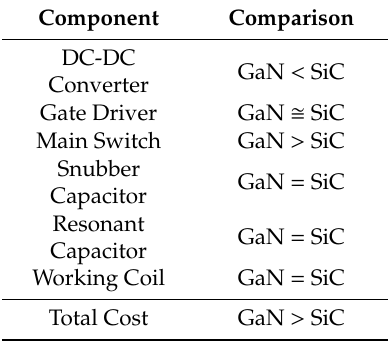
Table 3. Comparison of system components.